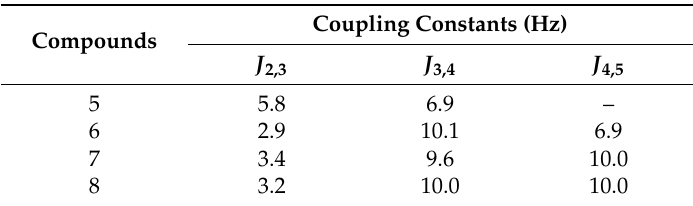
Table 1. Coupling constants of rhamnopyranosides 5 – 8 .